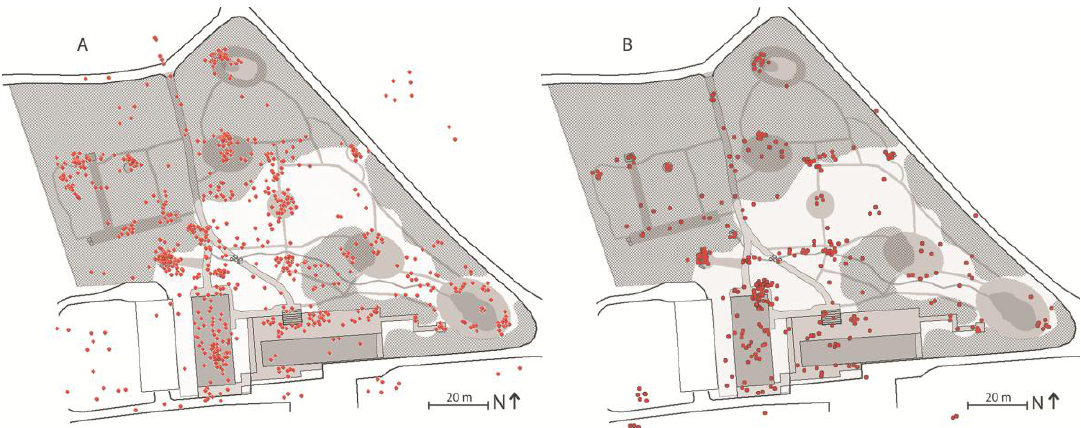
Figure 7. Graphical data from logbooks ( A ) and behaviour mapping ( B ) illustrating the general use distribution in Nacadia ® .